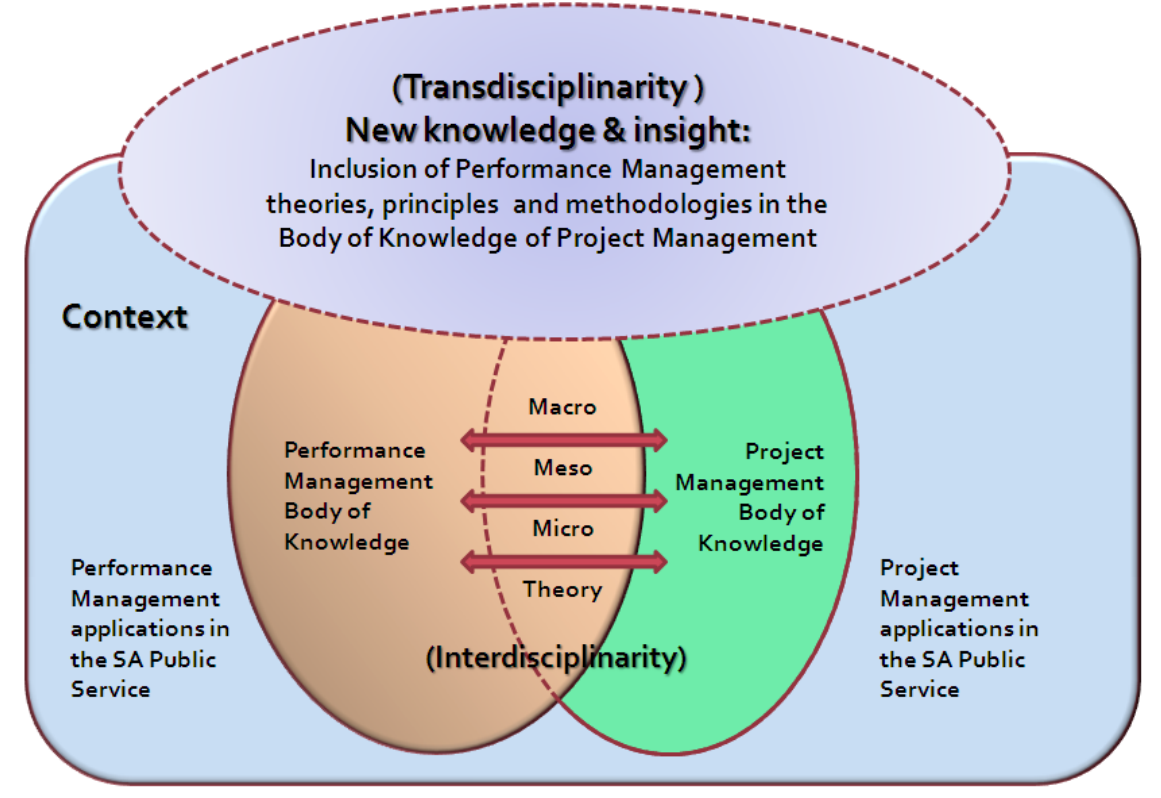
Fig. 2 Performance Management and Project Management: Transdisciplinary